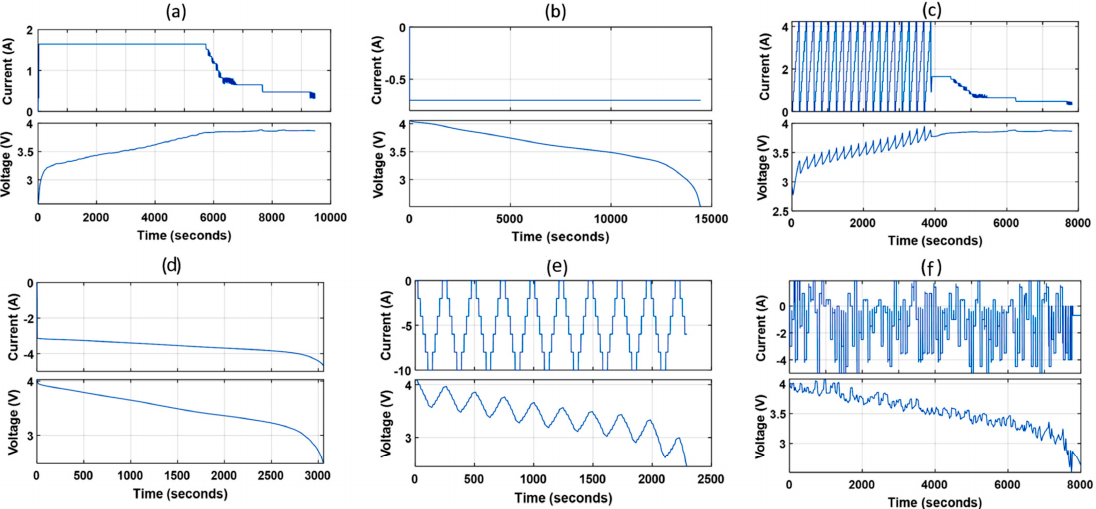
Figure 3. Characteristics of the major profiles used for cell aging. ( a ) constant current (1.75 A) constant voltage charge; ( b ) constant current (0.7 A) discharge; ( c ) step current (0 A to 4.23 A) charge; ( d ) pack constant power discharge (75 W); ( e ) step current (0 A to − 10 A) discharge; ( f ) dynamic current